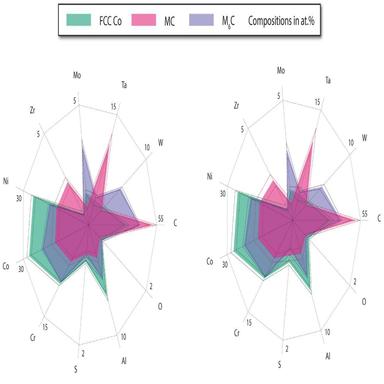
Average chemistry of the three identified phases in the dataset presented through this work. As with,c,e,g; and this analysis was performed with a variance tolerance, t, of 0.2% and an EBSD weighting, w, of 1. Filled regions plot average composition, dotted lines show +/- a standard deviation from the mean (tabulated data for this is provided in the supplementary information). This is shown for directly quantified RC-spectra (a) and average spectra assigned to the sam